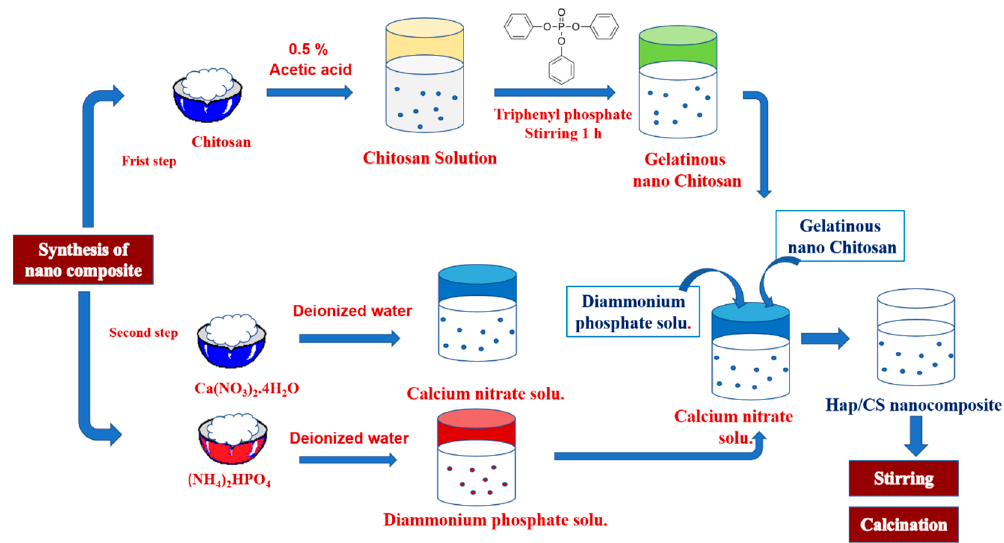
Figure 13. Synthesis of the Hap/CS nanocomposite.